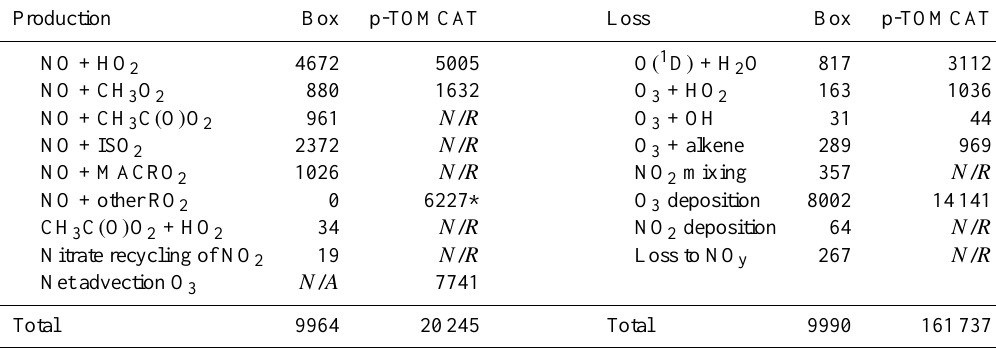
Table 3. Budget statistics for integrated O x in [pptv day − 1 ]. Values not reported are shown as N / R , values not applicable are shown as N / A , and * indicates that N / R represents a sum of the fluxes.